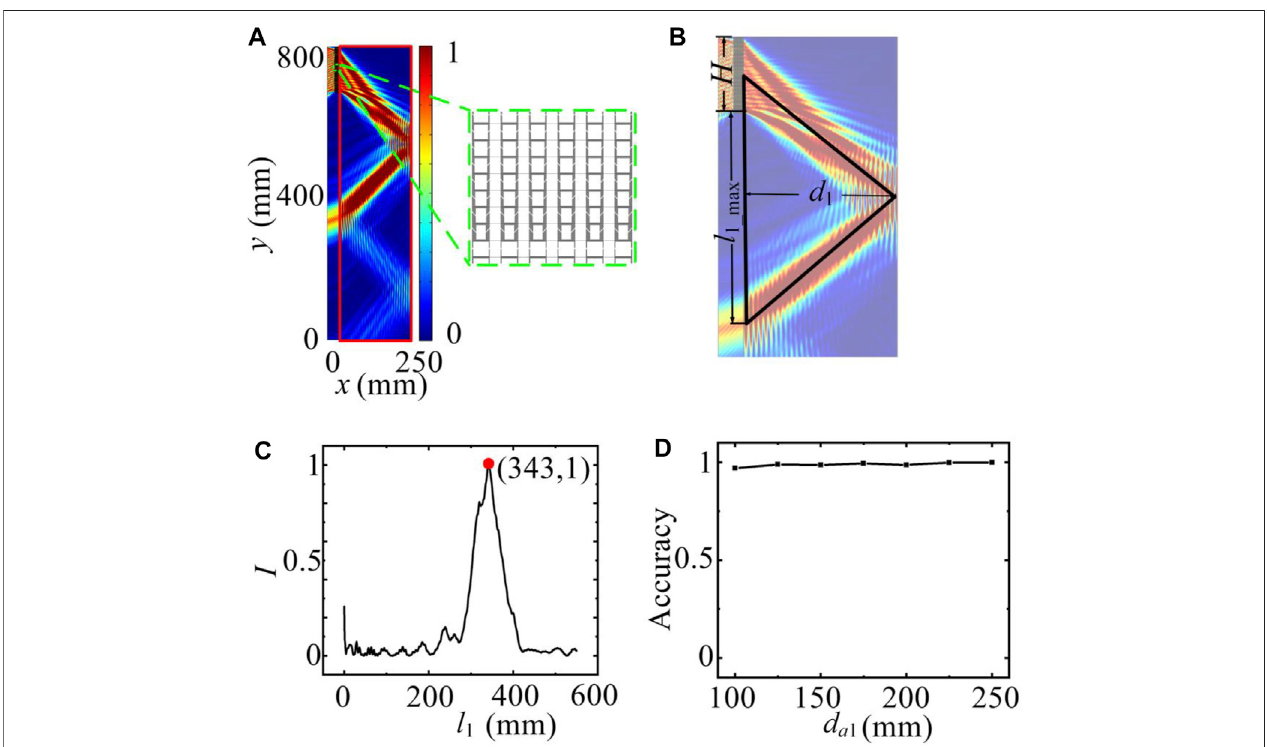
FIGURE 3 | Thickness evaluation based on the collimated and directional ultrasound emission with the metasurface. (A) Spatial distribution of the ultrasound intensity in evaluating the thickness of the rectangular plexiglass block (indicated by the red solid box). The enlarged view of the planar metasurface is partially shown in thegreendashedbox. (B) Trajectoriesofthedirectionalultrasoundbeamemittedfromthemetasurfaceandre fl ectedfromthedetectedplexiglassblock. (C) Ultrasound intensity distribution along the left surface of the plexiglass block, as a function of the distance l 1 from the bottom of the metasurface. (D) The evaluation accuracy with the ultrasound metasurface for evaluating the plexiglass blocks of different